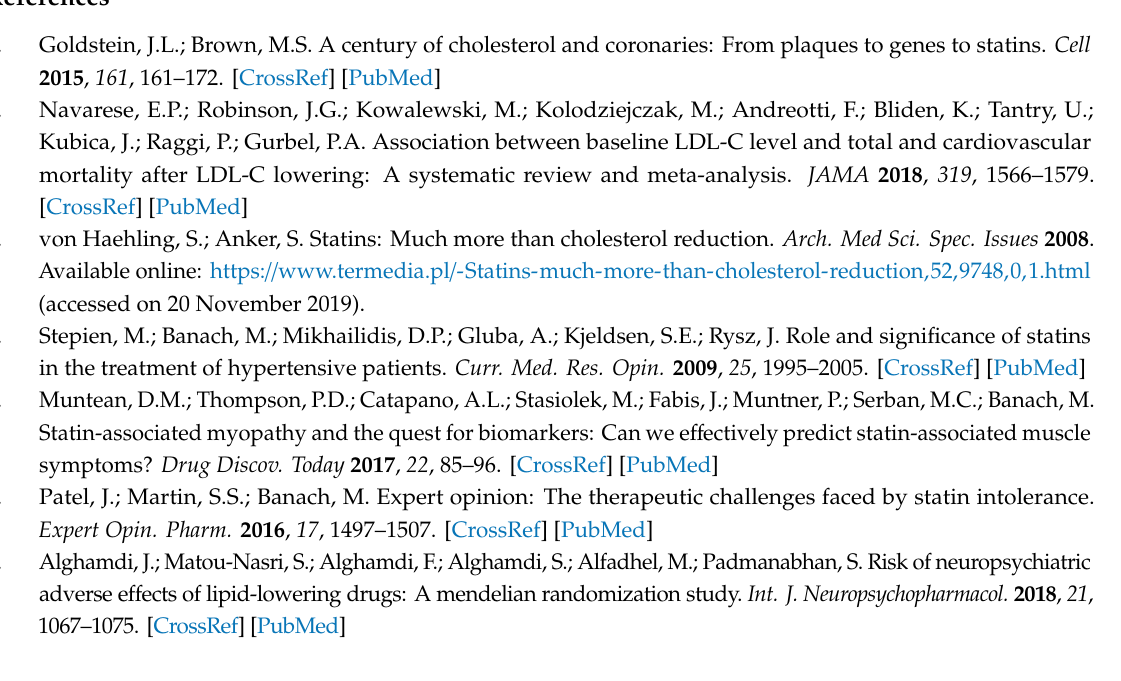
Figure S1. Cell viability of HepG2 cells following di ff erent concentrations of 5-uRCK or 5-uRCC exposure were measured by MTT assay; Figure S2. E ff ects of 5-uRCK and ellagic acid (EA) on body weights in rats fed a high-cholesterol diet